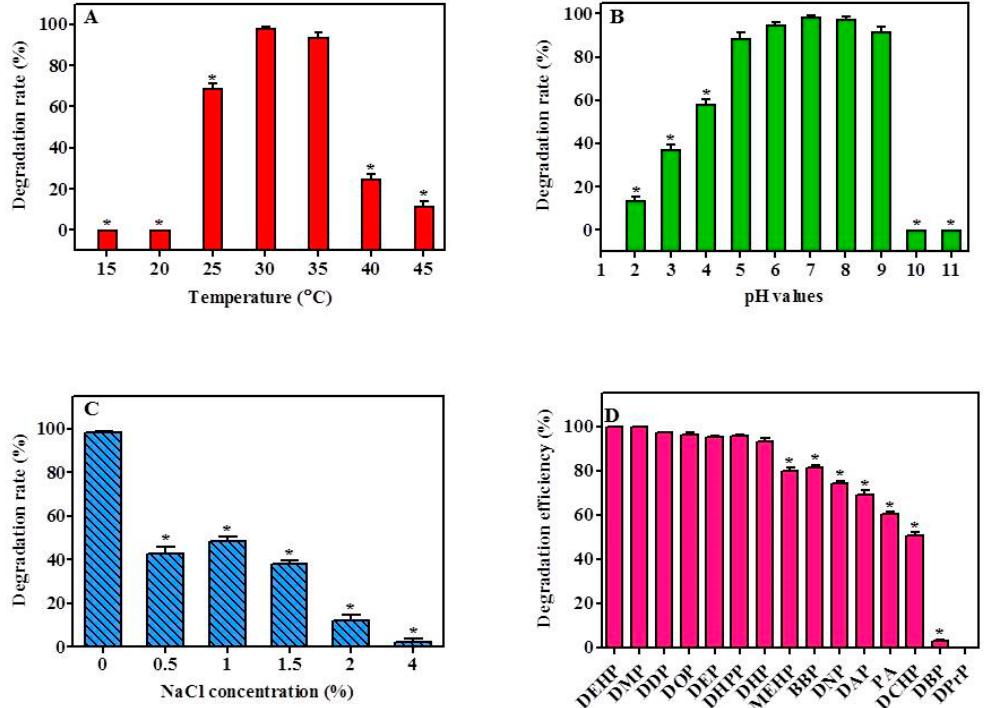
Figure 3. E ff ect of environmental factors on DEHP degradation rate by strain YC-IL1: ( A ), E ff ect of temperature; ( B ), e ff ect of pH; ( C ), e ff ect of NaCl concentration; ( D ), degradation rates of PAEs by the strain YC-IL1. The initial concentration was 100 mg / L and the degradation rate was calculated as a percentage of the transformed amount of DEHP. The degradation rate was recorded after 7 days incubation. Data represent the mean ± SEM of three independent replicates. * indicates the significant di ff erence ( p < 0.05; one-way ANOVA followed by Dunnett’s test) between the columns denoted with (*) and control; the controls are 30 ◦ C for temperature e ff ect, pH 7 for the pH e ff ect, 0% for the NaCl concentration e ff ect, and DEHP for PAEs degradation e ffi